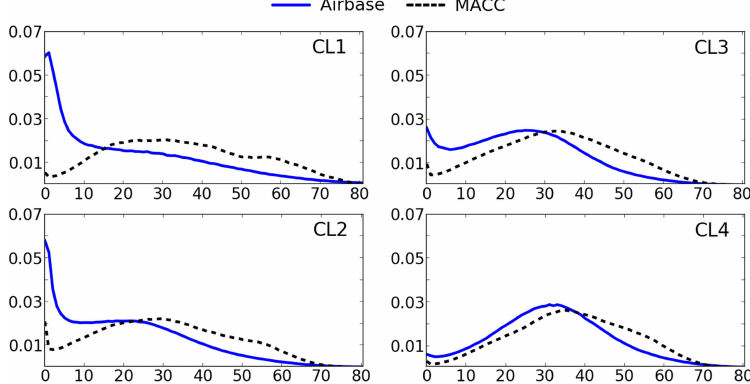
Figure 10. Normalized frequency distributions of 3-hourly ozone values in clusters (2007–2010); Airbase vs. MACC, second